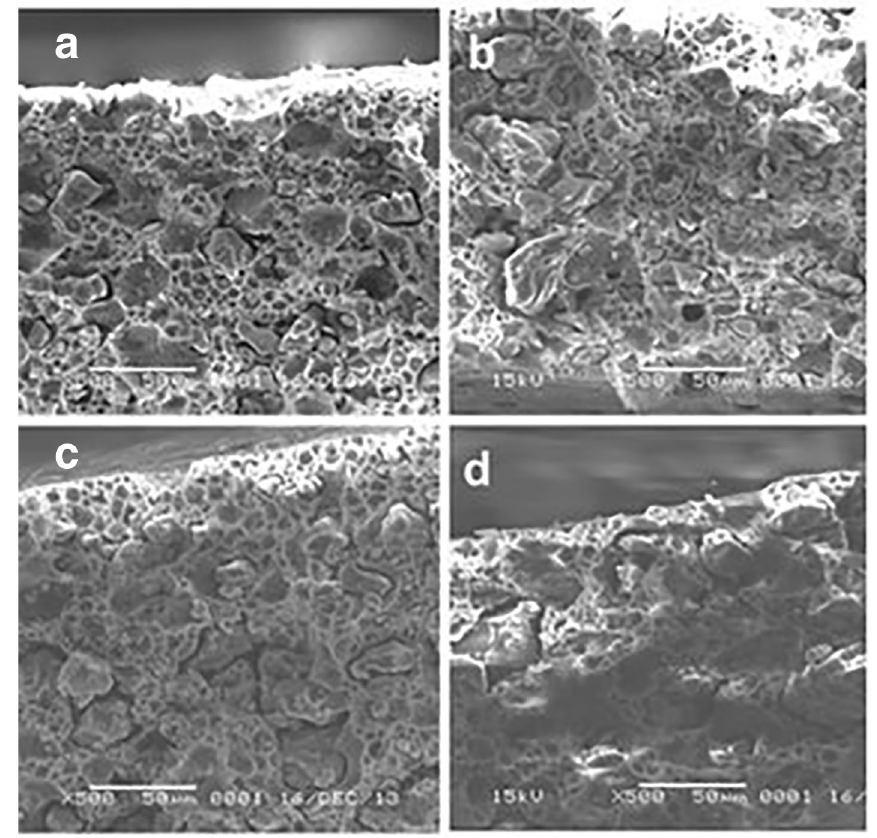
Fig. 10 Scanning electron microscope cross sections of polysulfone membrane